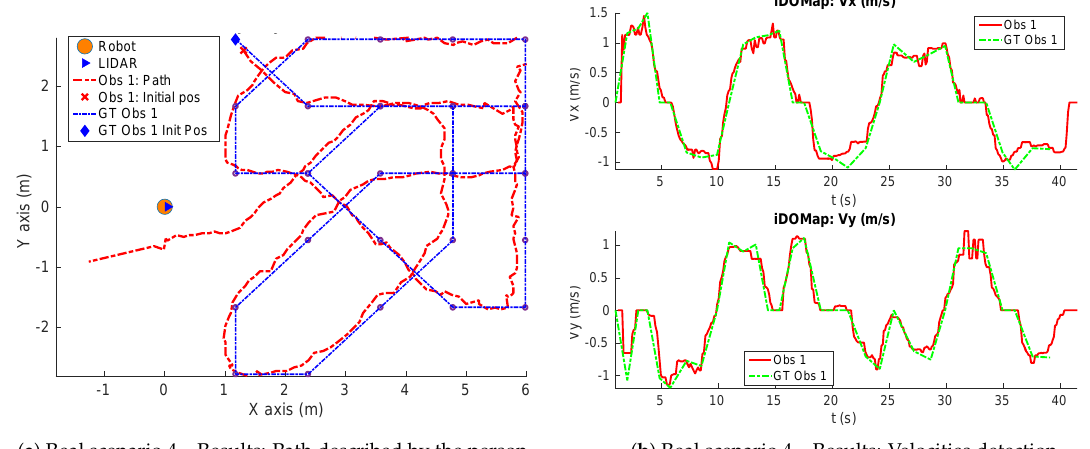
( b ) Real scenario 4—Results: Velocities detection. Figure 20. Real scenario 4—Path and Velocities detection.